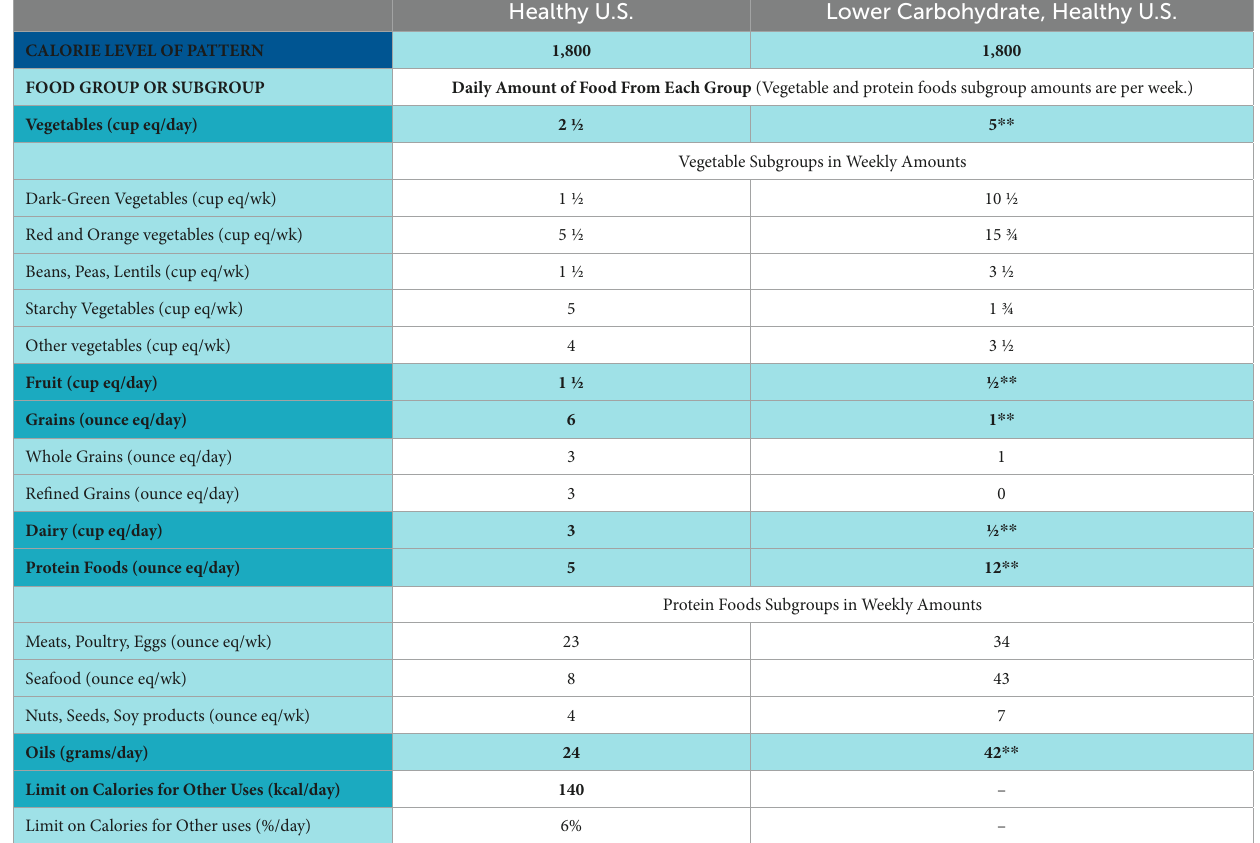
TABLE 1 Healthy U.S.-Style Dietary Pattern for Ages 2 and Older, With Daily or Weekly Amounts From Food Groups, Subgroups, and Components (meets Thrifty Food Plan * ). Healthy